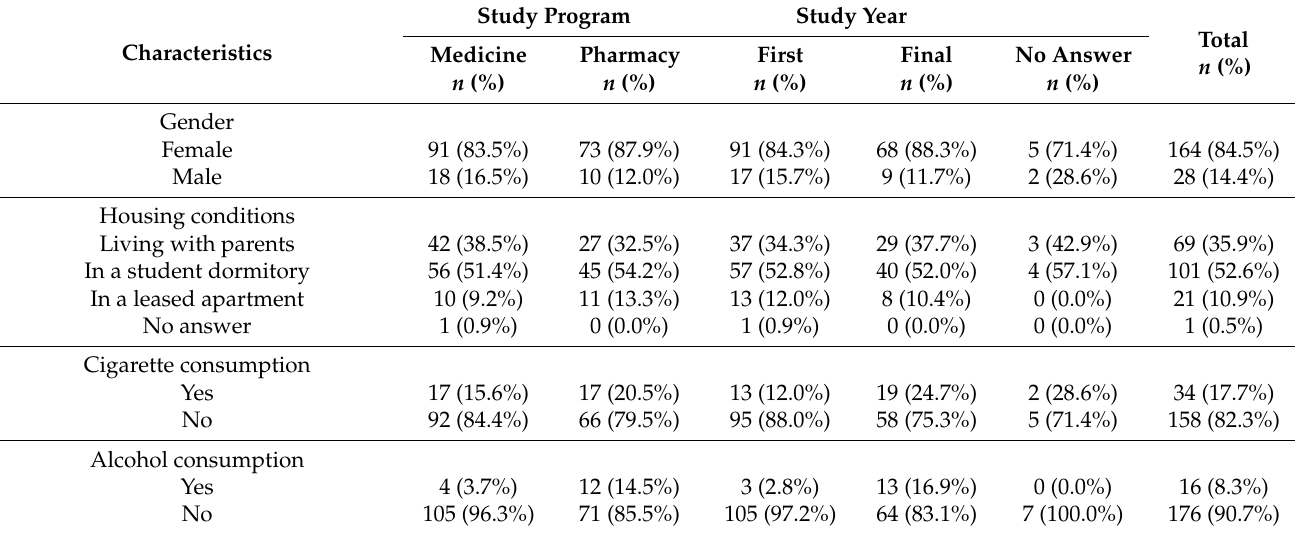
Table 1. Socio-demographic profile and living habits of respondents ( n =